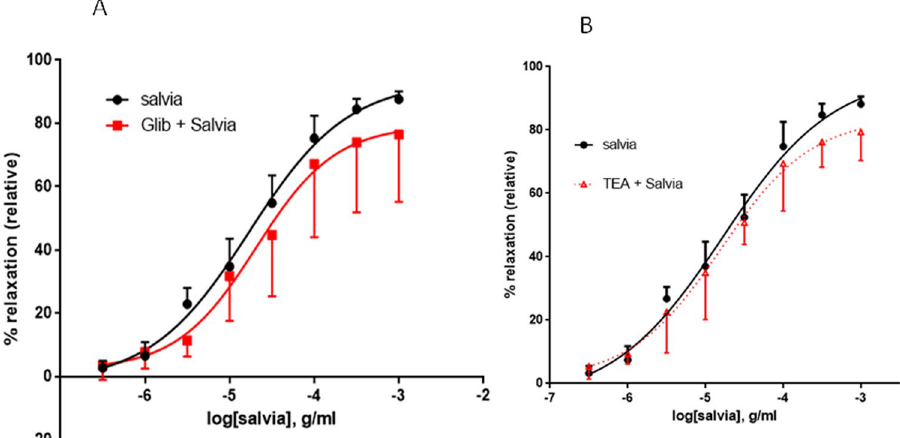
Figure 7. Role of potassium channels in SF-induced relaxation of aortic rings. Endothelium-intact rings were incubated with cumulative doses of SF in the absence (Salvia plus vehicle; filled circles) or presence of ( A ) 10 µ M of Glibenclamide (Glib + Salvia; squares), or ( B ) Tetraethylammonium (100 µ M) (TEA + Salvia; triangles). n = 6 or 5 for glibenclamide or TEA experiments, respectively. In both cases, no difference was noted between inhibitor treated and vehicle administered curves; p > 0.05 for Salvia alone versus either Glib + Salvia or Salvia + TEA.